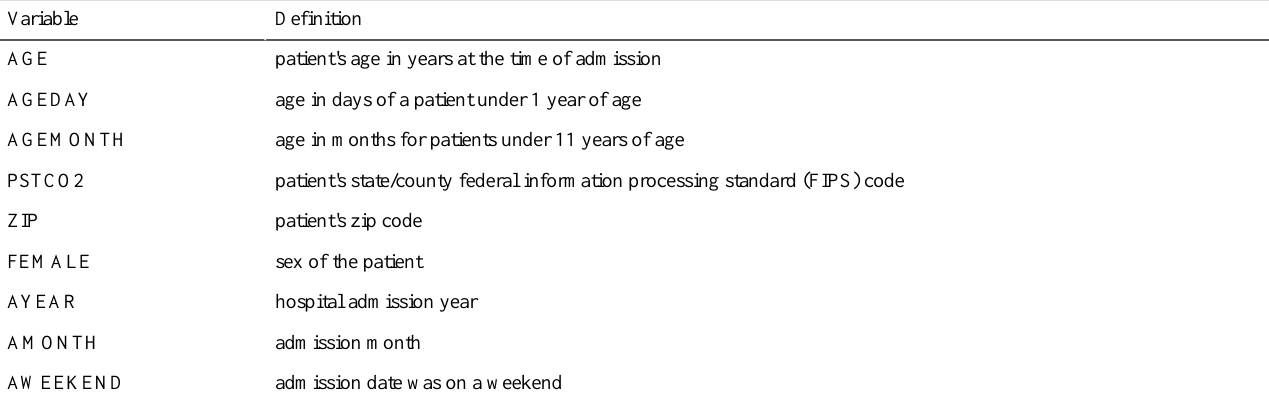
Table 5. Quasi-identifiers included in the analysis of the Washington State Inpatient Database (SID) dataset.